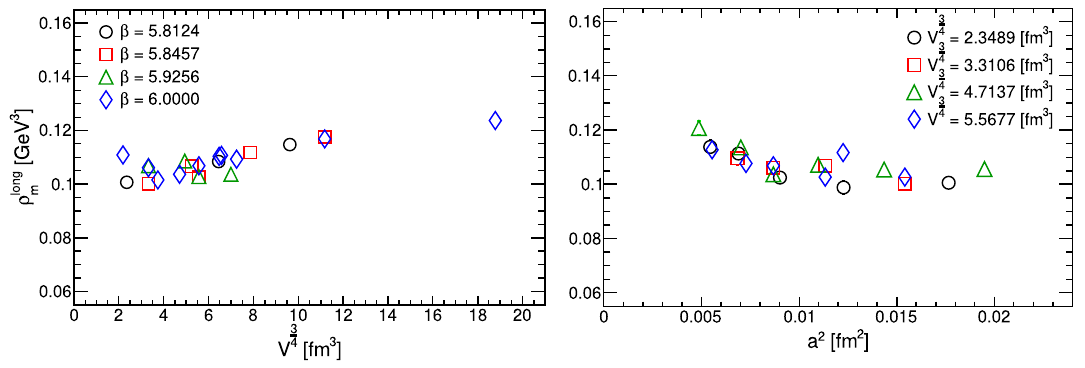
Fig. 1 The number density of the monopoles and anti-monopoles of the standard configurations. The left panel shows the effects of the finite lattice volume on the numerical results of the configurations of